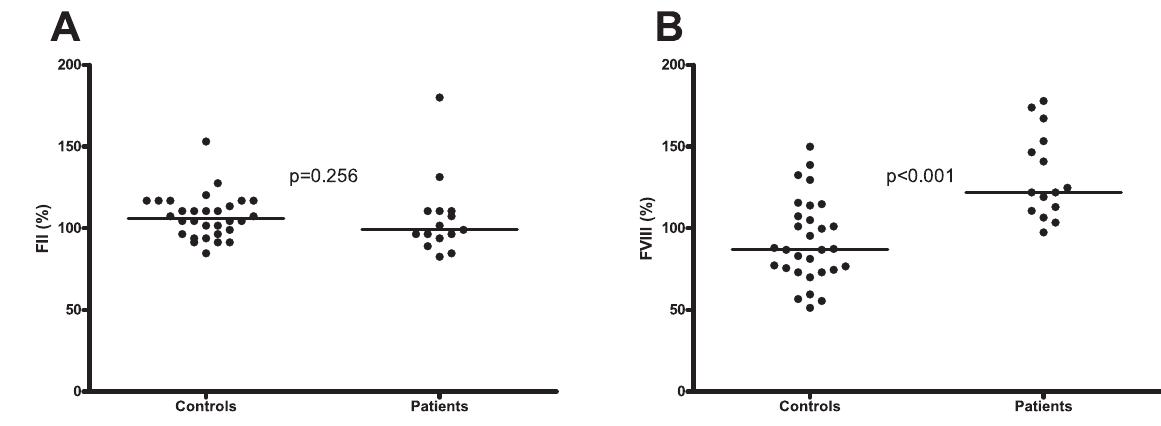
Figure 3. Coagulation factor levels in patients and healthy controls. A . Plasma levels of factor II in patients and healthy controls. B . Factor VIII plasma levels in patients and healthy controls. Horizontal bars indicate